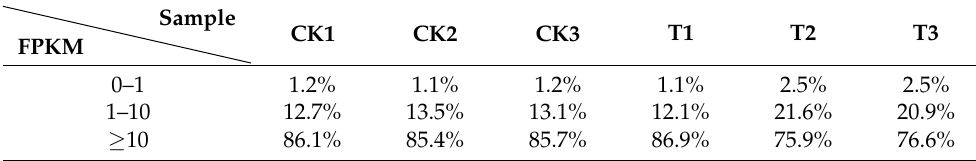
Table 3. Differential expression analysis of different stains.